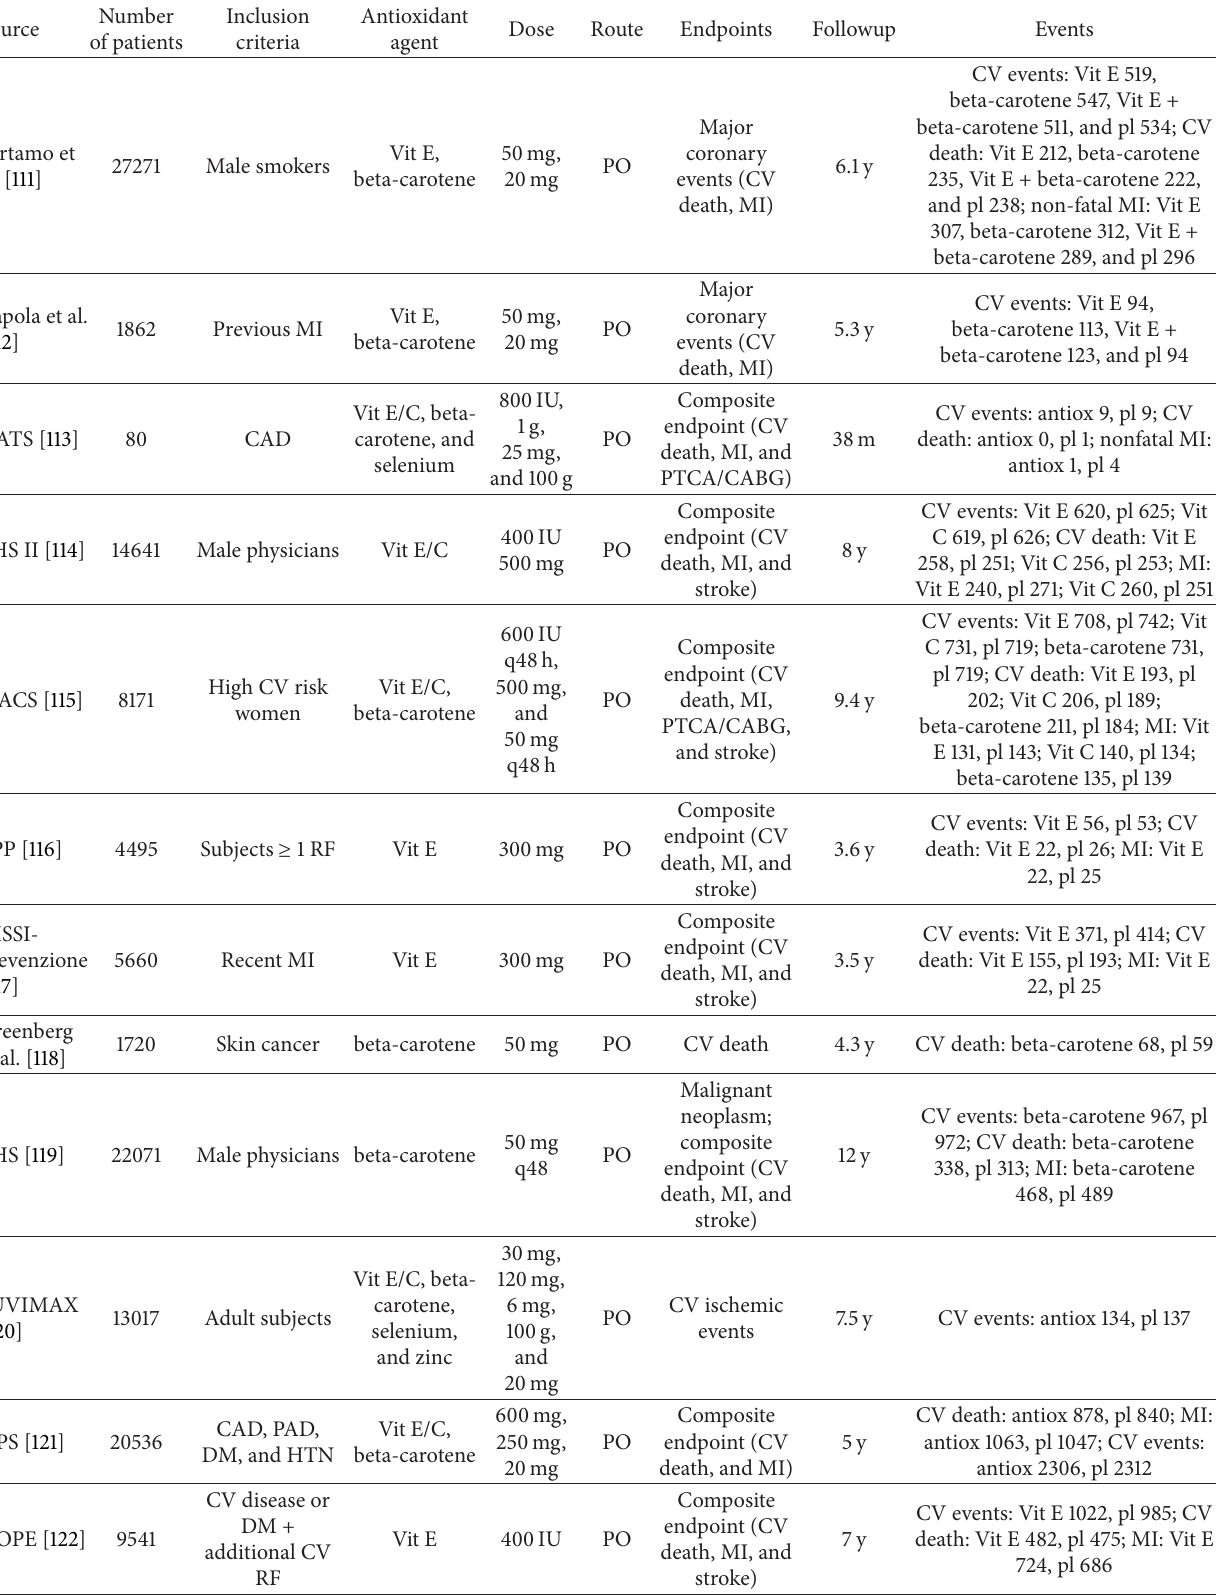
Table 4: Randomized controlled trials demonstrating no effect of antioxidant